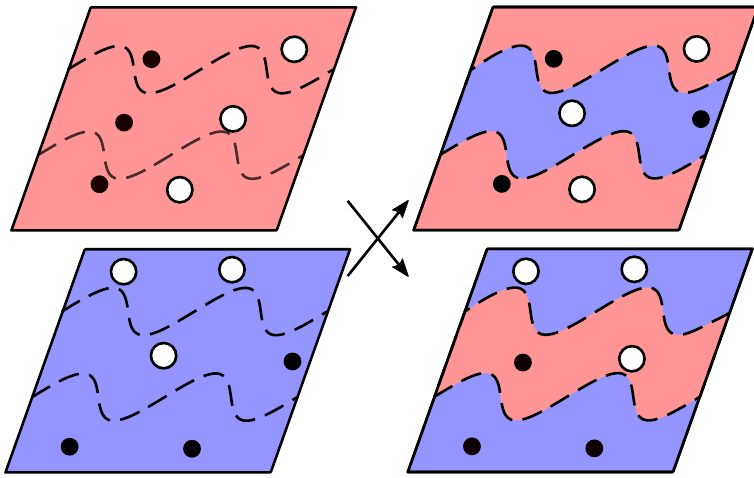
Figure 2. Real-space crossover of two unit cells, each containing six atoms across two different atomic elements (black and white circles) in two dimensions using a pair of periodic cuts (dashed lines). The cuts define two sets of atoms for each of the parents ( left ): the ‘inner’ set comprises atoms lying between the two cuts; and the ‘outer’ set comprises the remainder of the atoms. Child structures ( right ) are formed by combining atoms from the ‘inner’ set of one parent, with those from the ‘outer’ set of the other